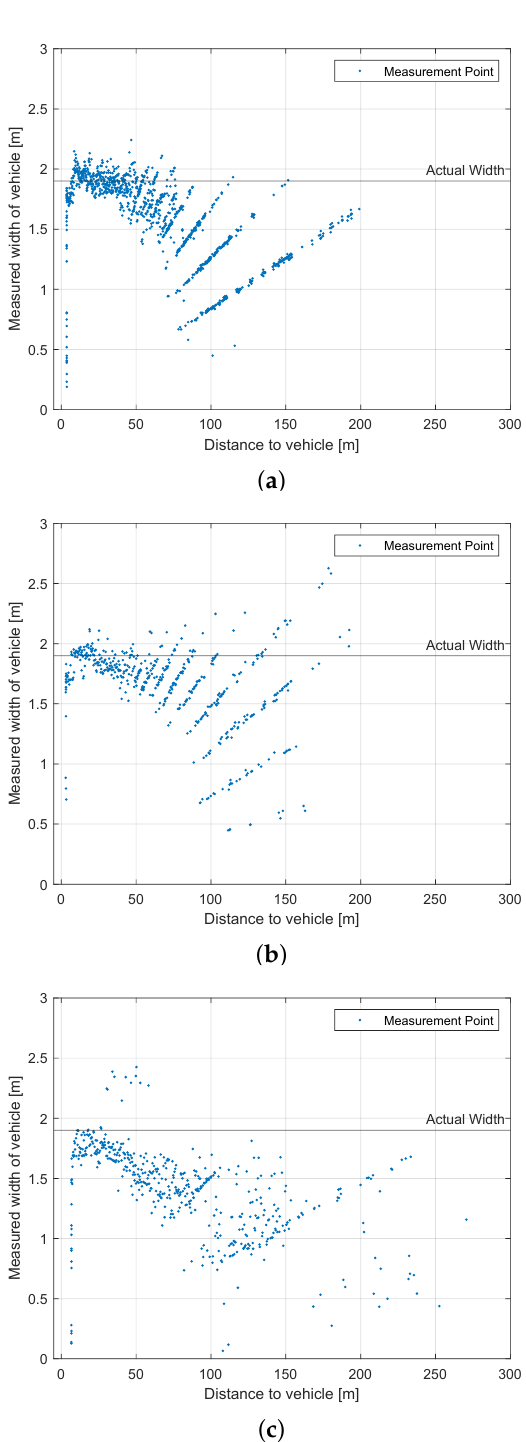
Figure 12. Results: Scenario ’Dynamic Vehicle Detection’. Measured width in relation to the distance to the second vehicle. ( a ) Velodyne Velarray (1175 vehicle detections); ( b ) Robosense M1 (522 vehicle detections); ( c ) Livox Horizon (468 vehicle